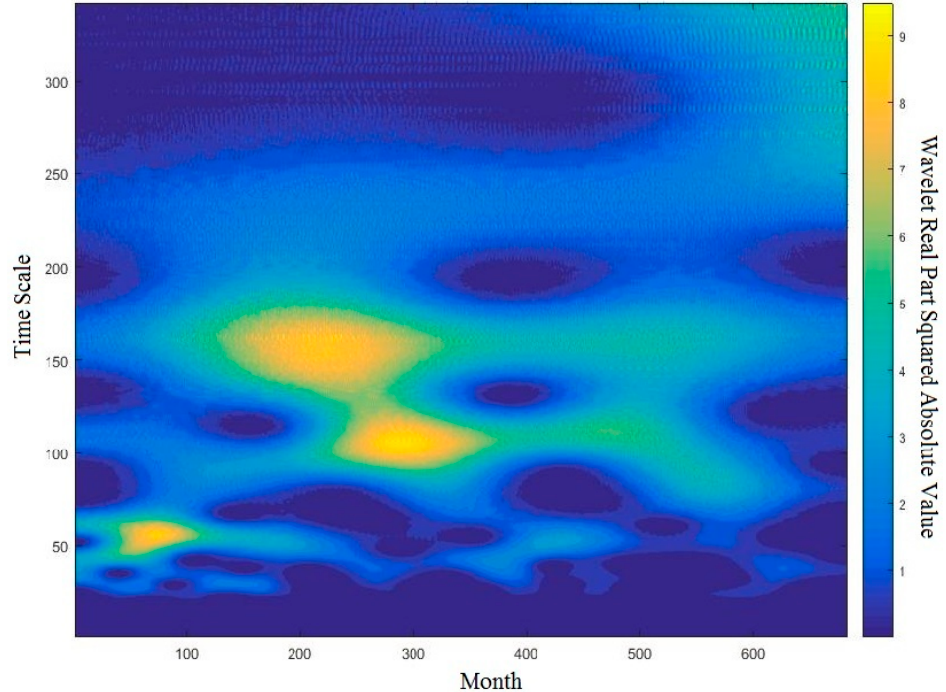
Figure 12. The Morlet wavelet power spectrum on SPEI12 time series.